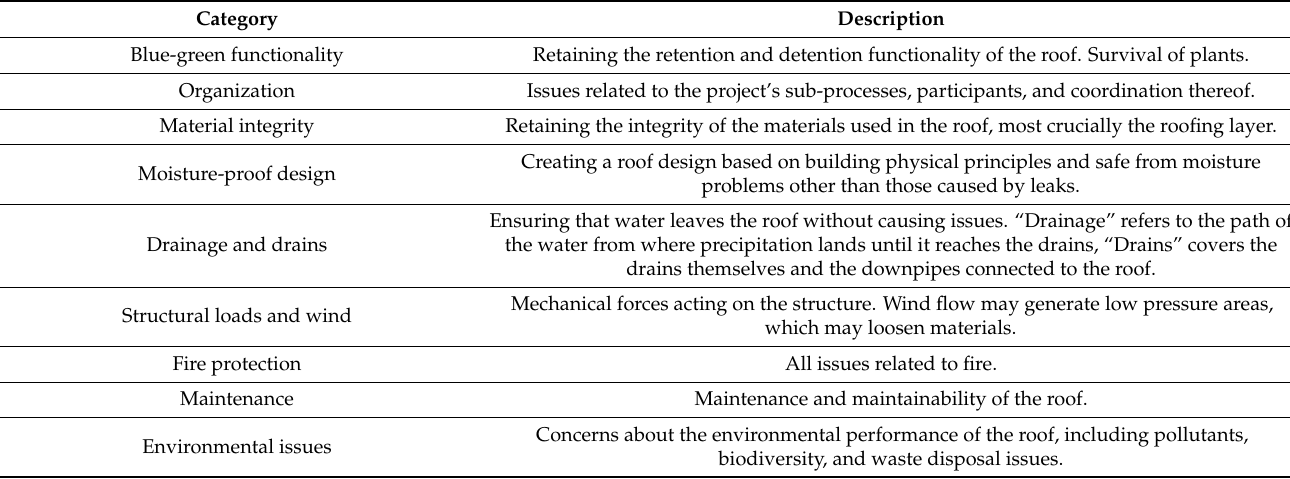
Table 1. Topic categories for attentions in the quality risk